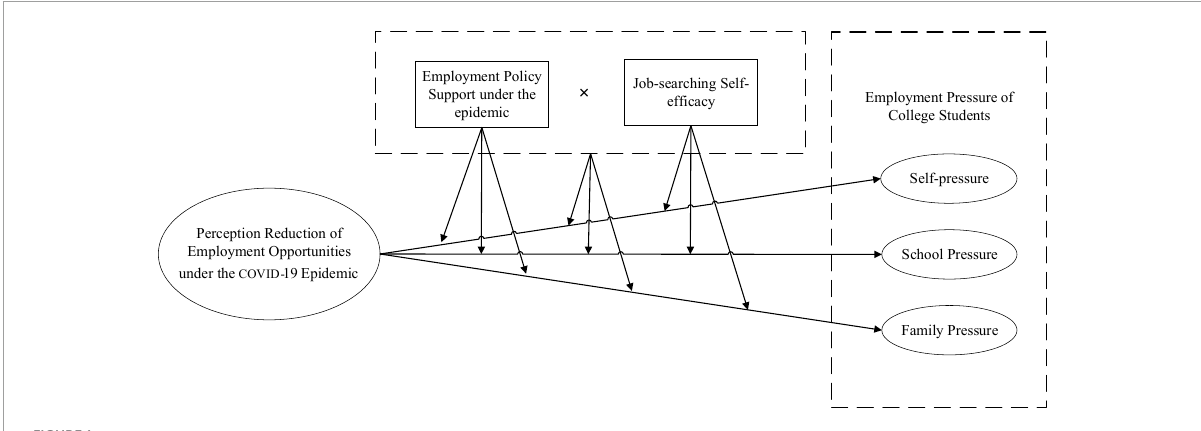
FIGURE1 The mechanism model between college students’ perception reduction of employment opportunities and their employment